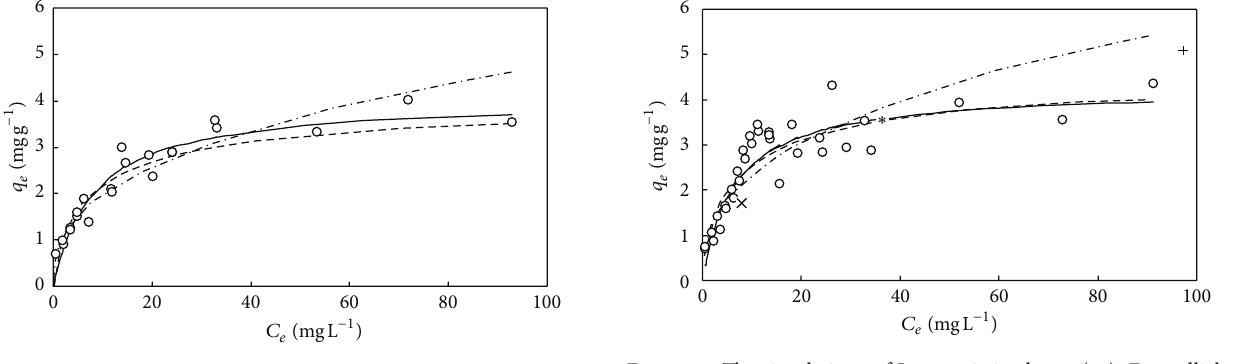
Figure 5: The simulations of Langmuir isotherm (—), Freundlich isotherm (- ⋅ -), and D-R isotherm (---) for adsorption of DMP on M-PVAL with pH 0 = 5. Final pH = 7.36–7.87. I : experimental data.